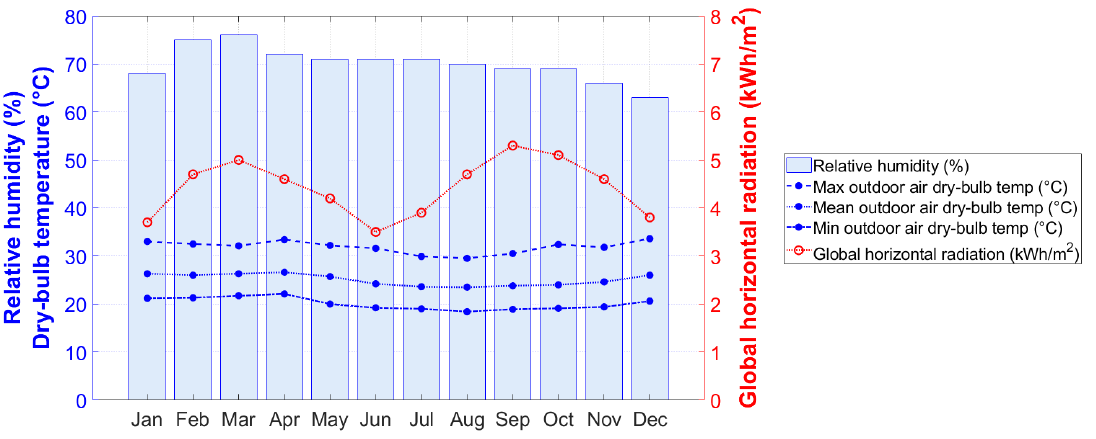
Figure 1. Climate conditions in Guayaquil, Ecuador for the typical meteorological year (TMY, source: Meteonorm